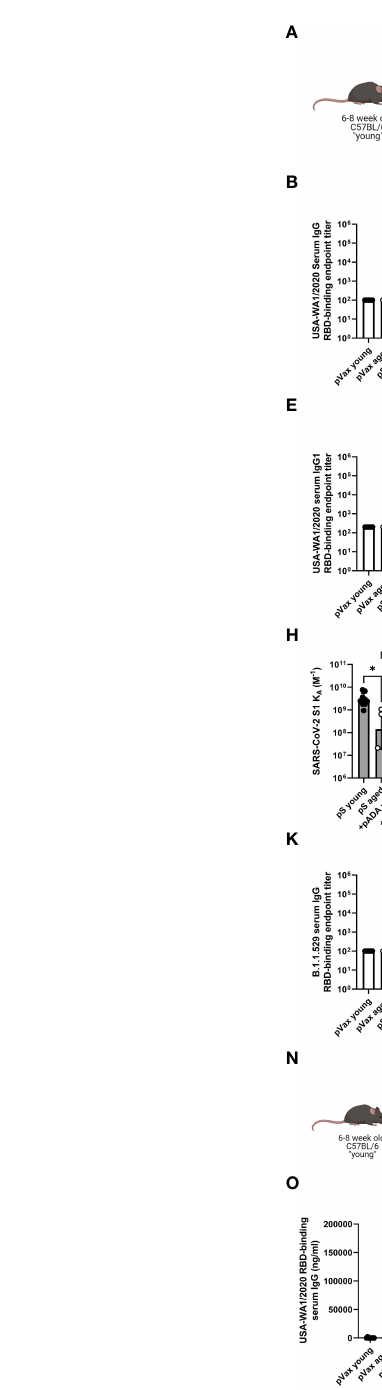
FIGURE 3 pADA co-immunization enhances SARS-CoV-2 humoral responses and promotes long-lived antibody responses in aged mice. Mice were immunized as in Figure 2 and antibody responses were evaluated 12-14 days post-2 nd immunization (A) . (B) Serum binding, (C) pseudovirus neutralization, and (D) live virus neutralization against SARS-CoV-2 parental (USA-WA1/2020). Serum binding IgG1 (E) , IgG2c (F) , and the ratio of IgG2c:IgG1 (G) . Serum antibody af fi nity as measured by surface plasmon resonance against parental SARS-CoV-2 S1 (H) , RBD (I) , and S2 (J) spike subunits. Omicron (B.1.529/BA.1) (K) , BA.2 (L) and BA.4/5 (M) RBD Serum binding endpoint titers. Mice were immunized twice separated by four weeks with pS alone or co-immunized with pS and pADA as in A, and antibody responses were evaluated 72 days post-2nd immunization (N) . (O) Serum binding, (P) pseudovirus neutralization, and (Q) live virus neutralization against SARS-CoV-2 parental (USA-WA1/2020) at 6072 days post second immunization. Data are representative of one experiment. Symbols represent the mean of duplicate assays for individual animals, bars represent the geometric mean, error bars represent the geometric standard deviation. *P<0.05, **P<0.01, ***P<0.001, and ****P<0.0001 by Mann- Whitney-U